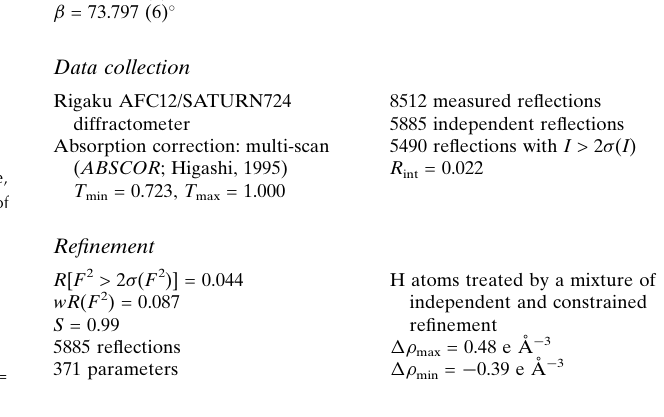
Hydrogen-bond geometry (A˚ , (cid:3) ). D —H (cid:2)(cid:2)(cid:2) A